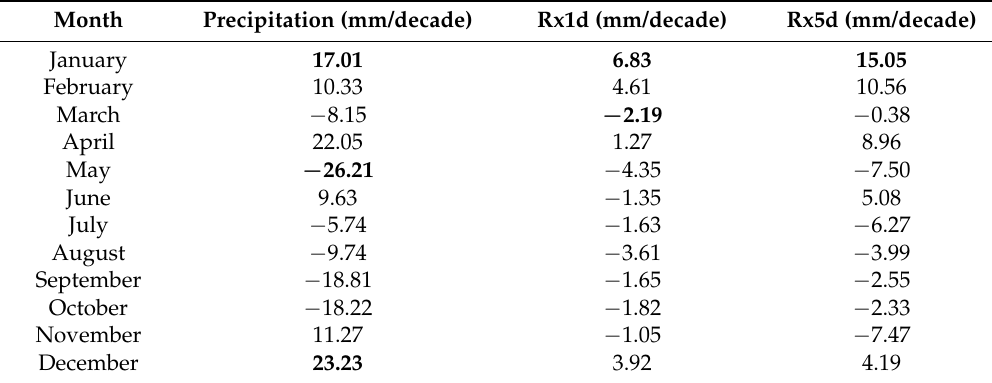
Table 3. Magnitude of the monthly precipitation, Rx1d, and Rx5d indices from 1985 to 2015. Bold color indicates significant trend at a 95% significance